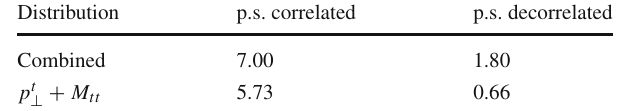
Table 2 χ 2 / N data values for fits to the ATLAS 8 TeV lepton + jet data, including decorrelation of the parton shower systematic uncertainty described in the text